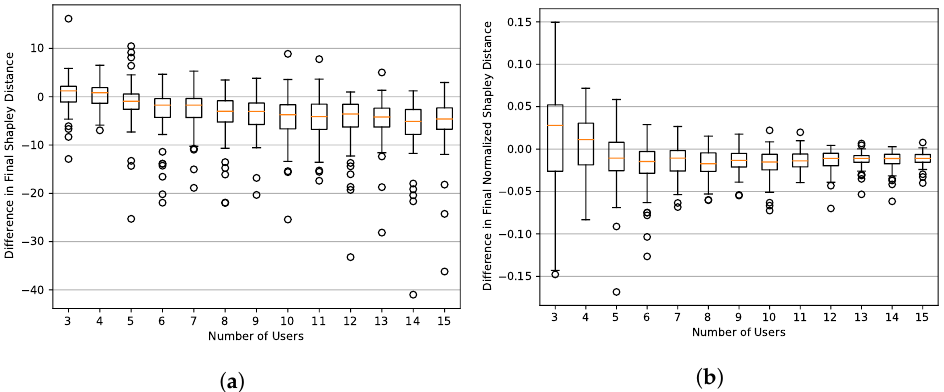
Figure 8. Boxplot of difference between final Shapley distance ( a ) and normalized Shapley distance ( b ) of day-wise and full-period nucleolus in 1000 trials separated by the number of users in the community. The difference in the final excess is of course always positive, i.e., the stability of the day-wise nucleolus is weaker than that of the full-period nucleolus. The absolute difference is rather independent of the number of users, while the normalized excess decreases with a higher number of users. The difference in the Shapley distance has a tendency to